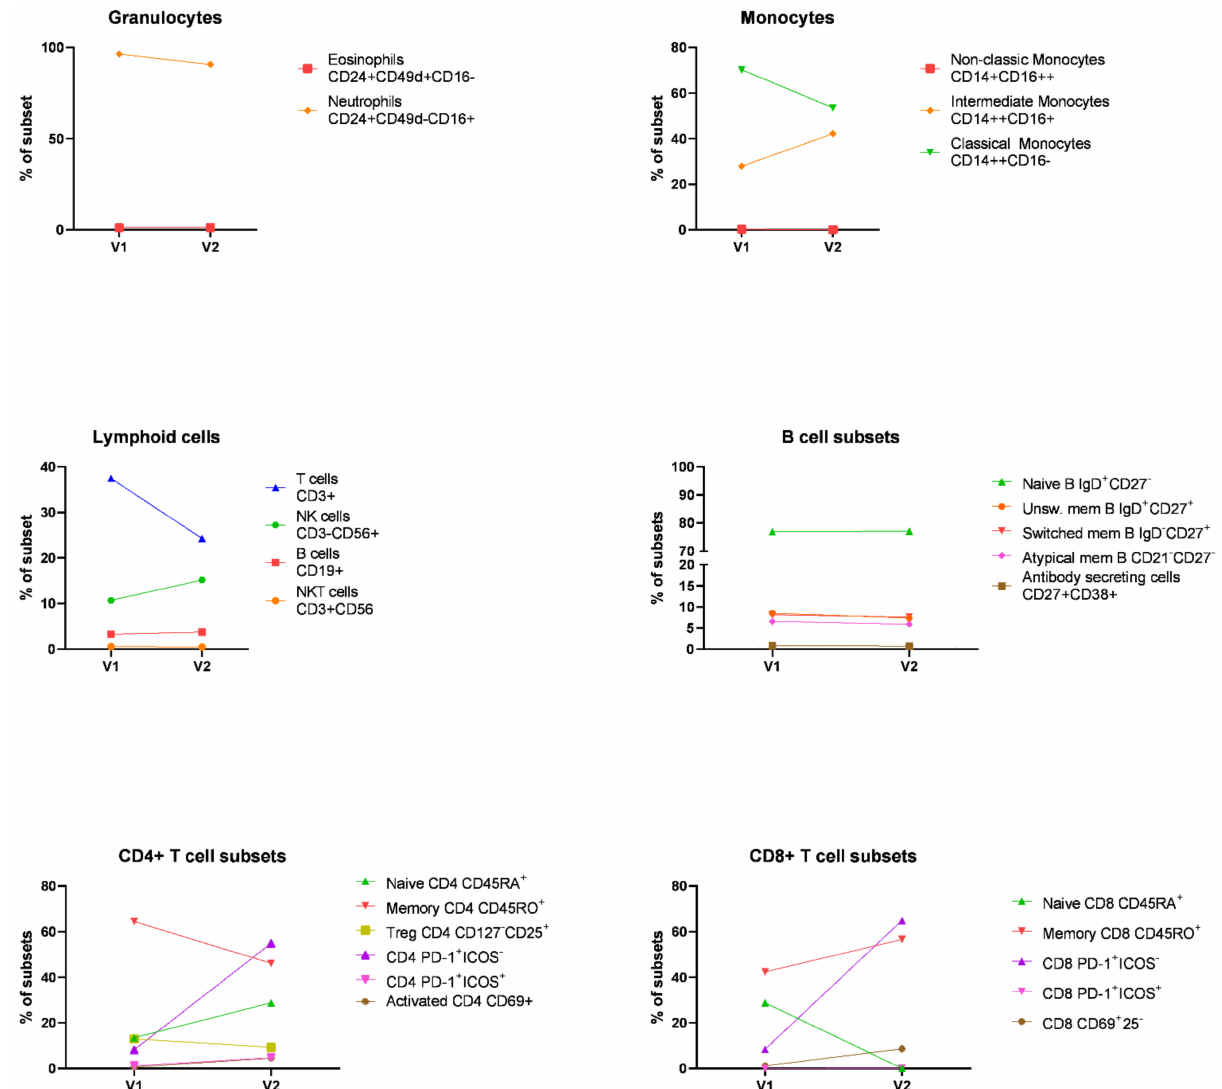
Figure 4. Peripheral blood immune cell profiling at the onset of toxicities. Immunophenotyping of granulocytes and mononuclear cells during immunosuppressive therapy at two timepoints after the onset of toxicities (visit 1 and 2) using flow